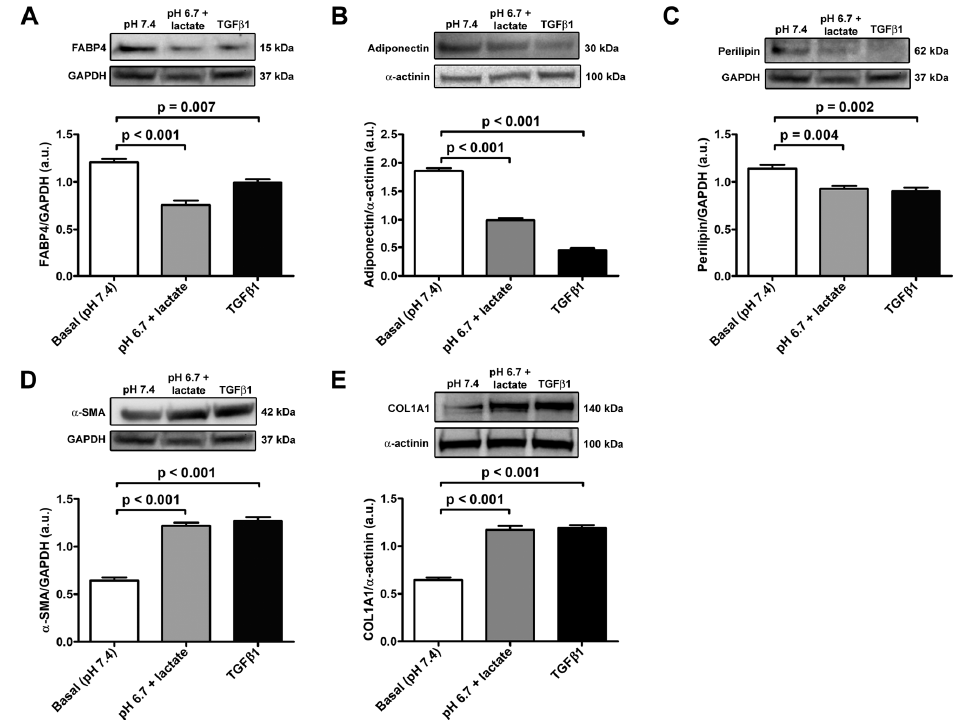
Figure 4. Representative bands of Western blot analysis and the relative quantification charts of the expression of the adipocytic markers FABP4 ( A ), adiponectin ( B ), and perilipin-1 ( C ) and the myofibroblastic markers α -SMA ( D ) and COL1A1 ( E ) in adipocyte-committed adipose-derived stem cells grown for 3 days under basal conditions (pH 7.4), lactic acidosis (pH 6.7 + lactate), or in the presence of 10 ng/mL TGF β 1. GAPDH and α -actinin were measured as loading controls for normalization. Molecular weight values (kDa) are indicated. Bars represent the mean ± SEM of optical density in arbitrary units (a.u.). Values of p were determined by Tukey(cid:31)s test.